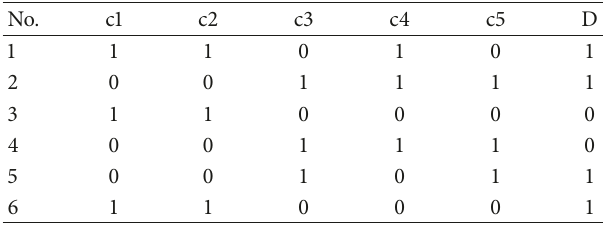
Table 2: Discrete results based on curve inflection